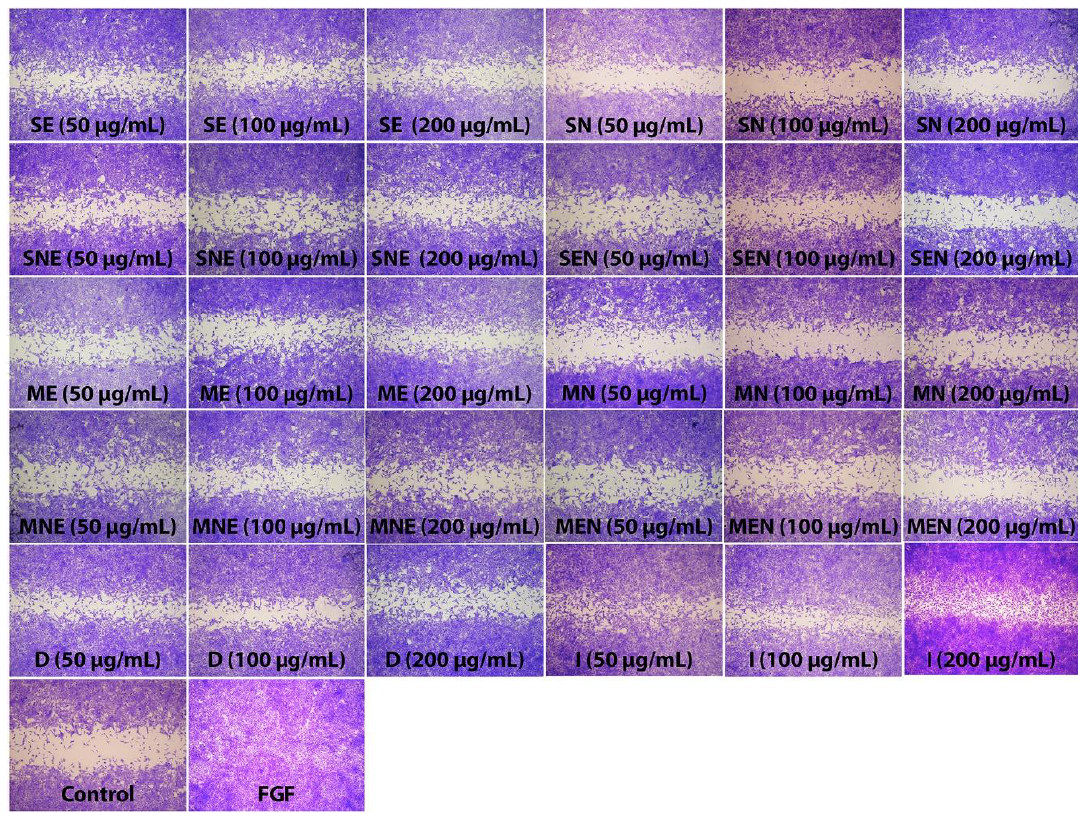
Figure 4. Representative images of each treatment group after 72h. Untreated fibroblasts were used as control. Fibroblast growth factor (FGF) (25 ng/mL) was used as positive control. SE — Soxhlet